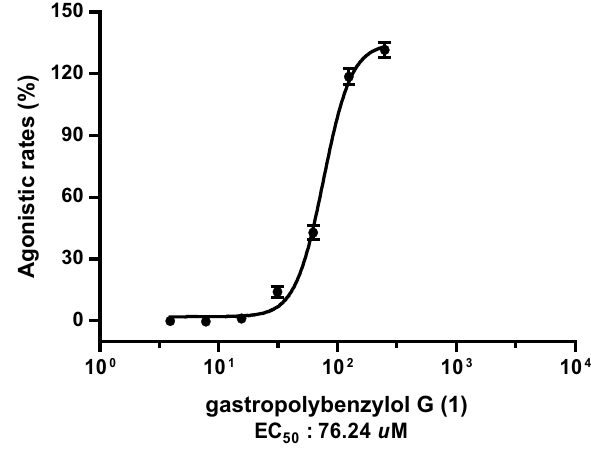
Fig. 4 Dose-dependent effects gastropolybenzylol G ( 1 ) on MT